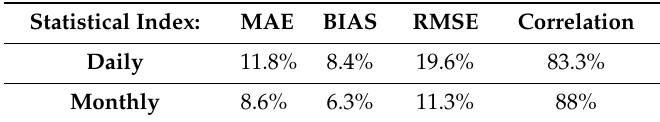
Table 5. Error indices and correlation coe ffi cient between recorded and simulated hydropower generation in 2005–2010.